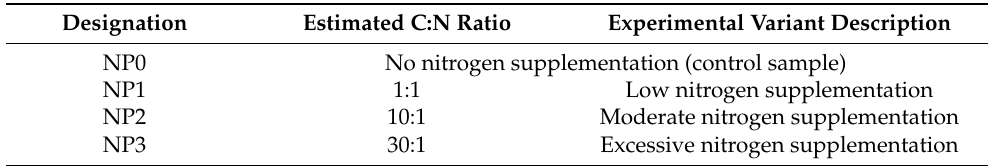
Table 1. Characteristics of the experimental